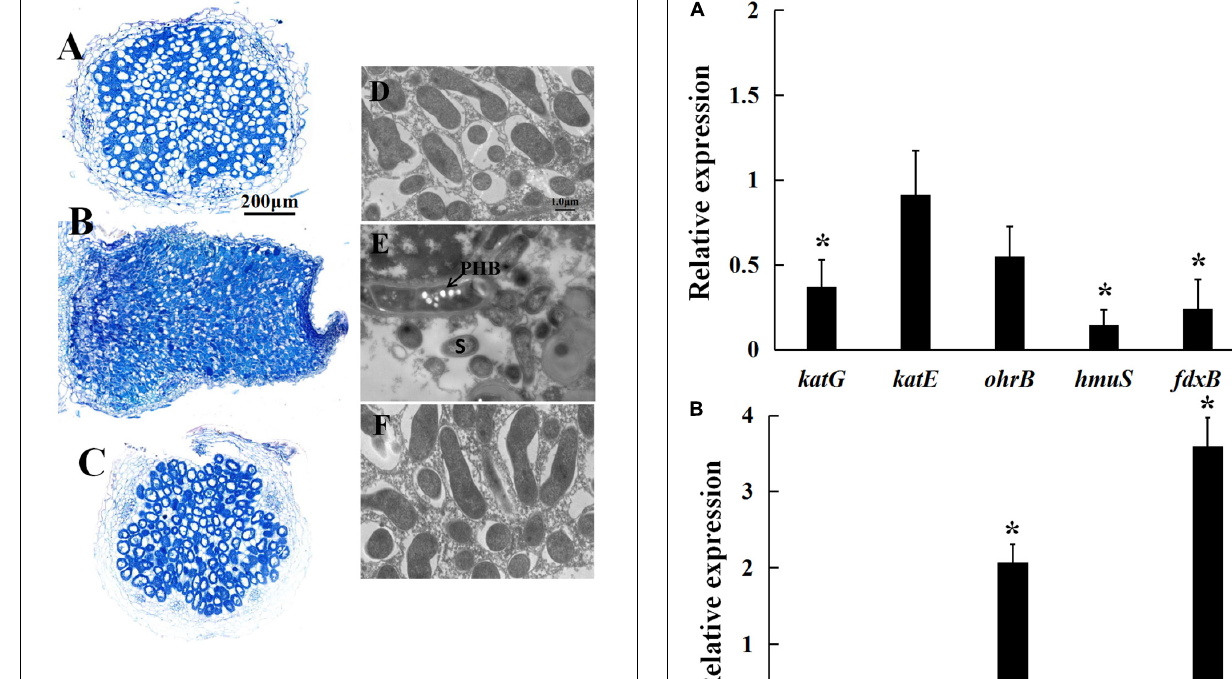
FIGURE 2 | Structure of 4-week-old pea nodules and bacteroids. Nodules were induced by RLgmcA(pBBRgmcA) (A,D) , RLgmcA (B,E) , RL3841 (C,F) . The wild-type RL3841 forms normal spherical (determinant) nodules (C) , while the gmcA mutant forms elongated nodules (B) . PHB, poly- β -hydroxybutyrate. S, senescing bacteroid. Scale bars = 200 µ m (A–C) and 1 µ m (D–F) .